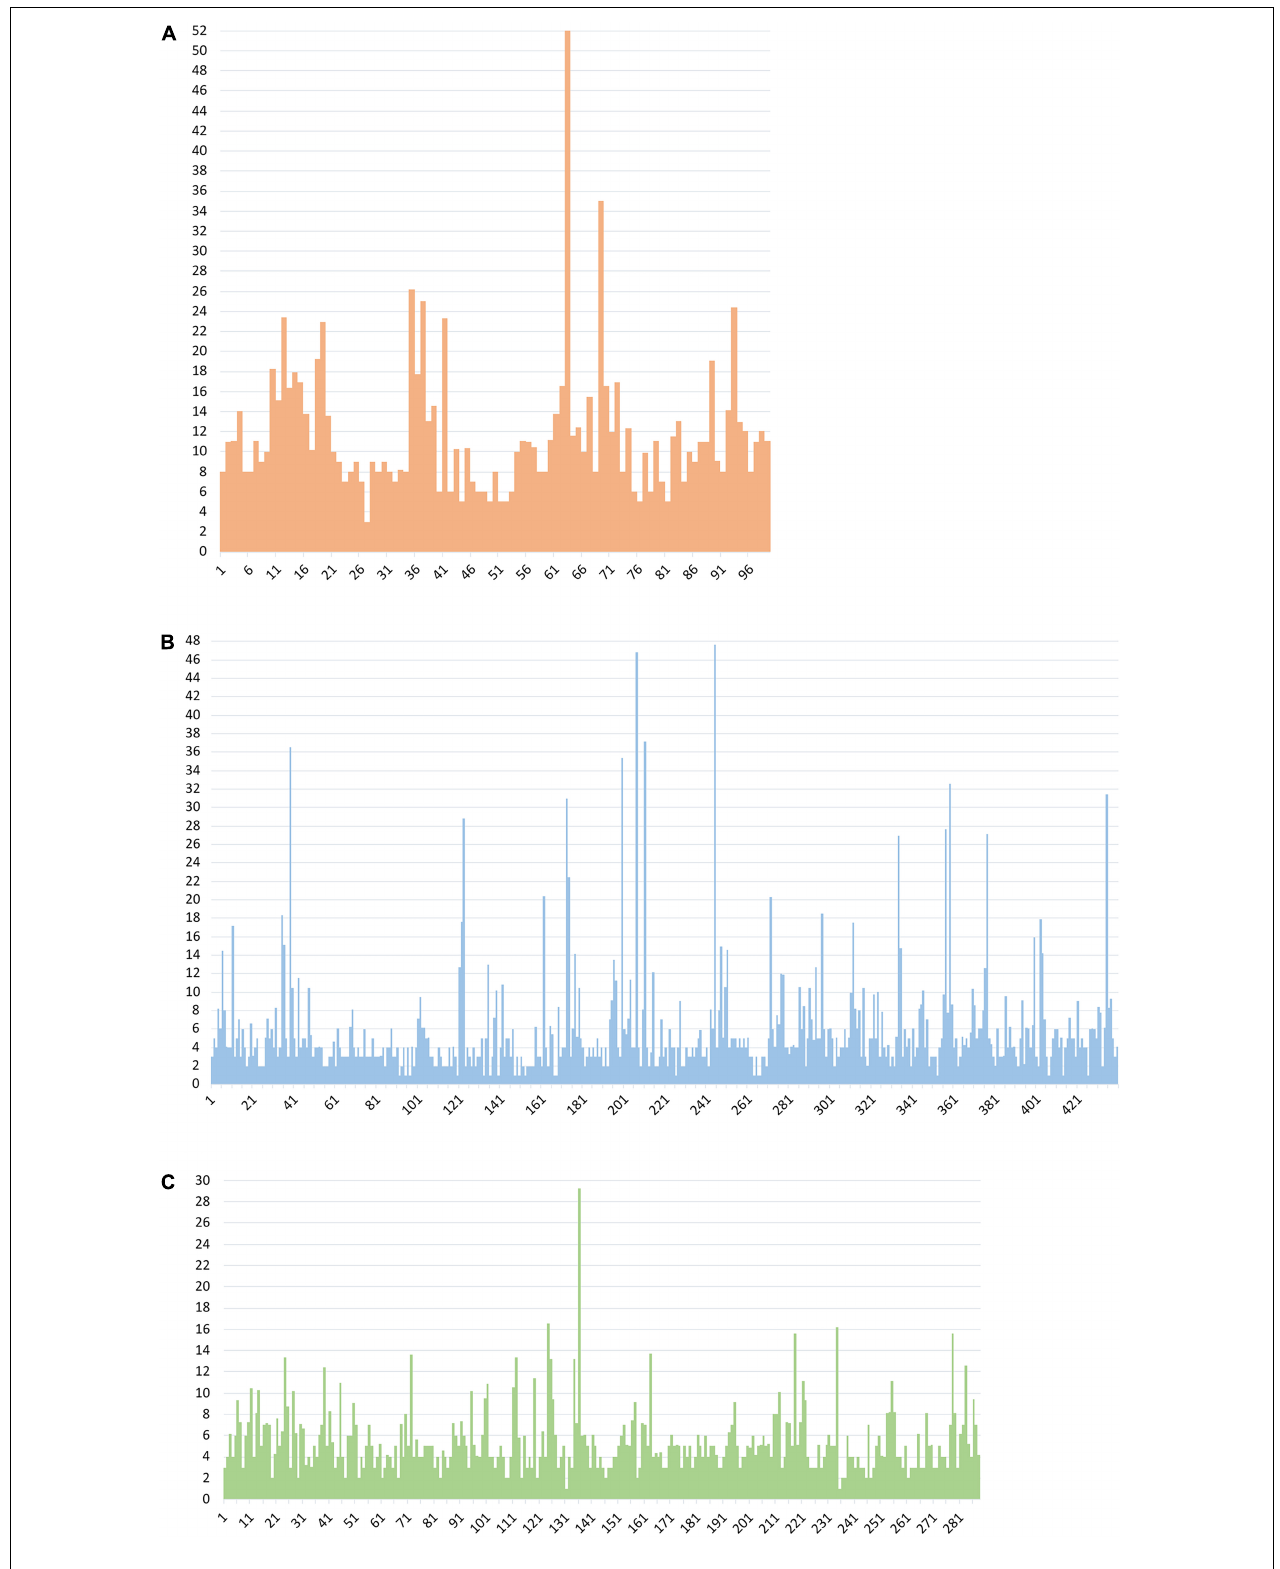
FIGURE 7 | Wu–Kabat variability coefficient plot of PR, RT, and IN group M sequences. (A) Wu–Kabat variability coefficient plot of PR (99 aa). (B) Wu–Kabat variability coefficient plot of RT (440 aa). (C) Wu–Kabat variability coefficient plot of IN (288 aa). X -axis, amino acid position; Y -axis, WK variability coefficient.